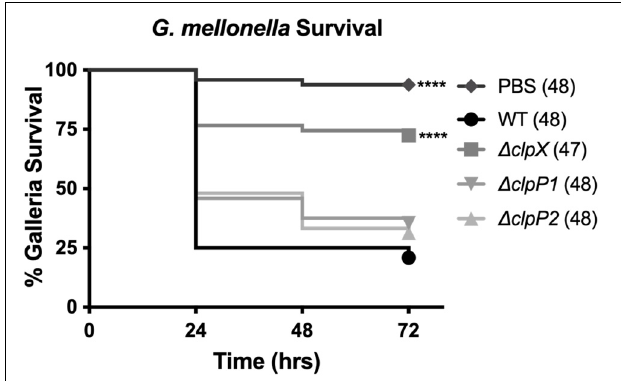
FIGURE 5 | Loss of clpP1 or clpP2 does not attenuate virulence in G. mellonella . Survival of larvae injected with PBS or wild-type B. anthracis Sterne (WT), (cid:49) clpX, (cid:49) clpP1 or (cid:49) clpP2. Each infection was repeated four independent times and total number of larvae for each condition are indicated in parentheses. Significantly different survival from larvae injected with WT represented by **** p < 0.0001 by the Mantel-Cox log rank